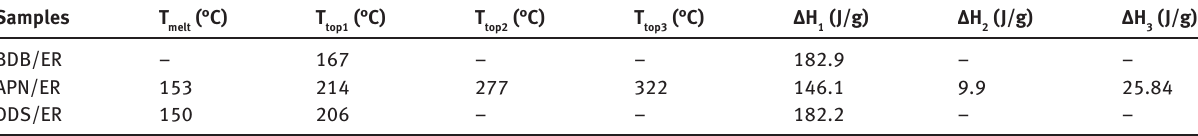
Table 1 Thermal curing properties of the amine/ER blends.